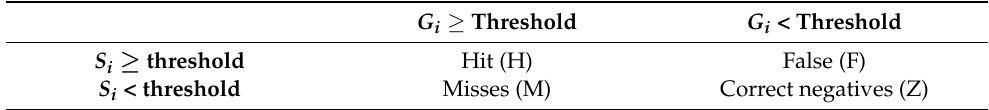
Table 3. Contingency table comparing precipitation detection by GSMaP data ( S i ) and gauge obser- vation ( G i ). G i ≥ Threshold G i <